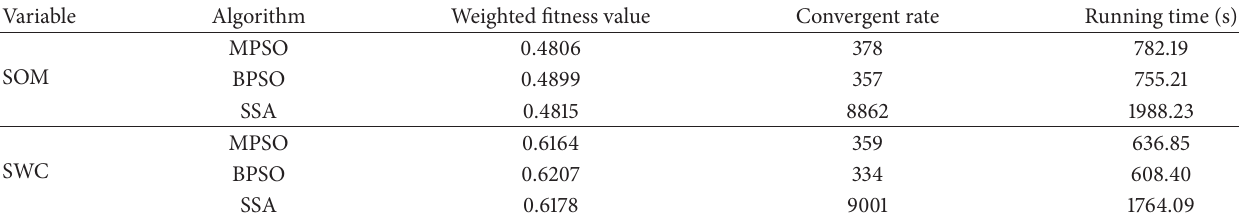
Table 3: Comparisons of the MPSO, the BPSO, and the SSA